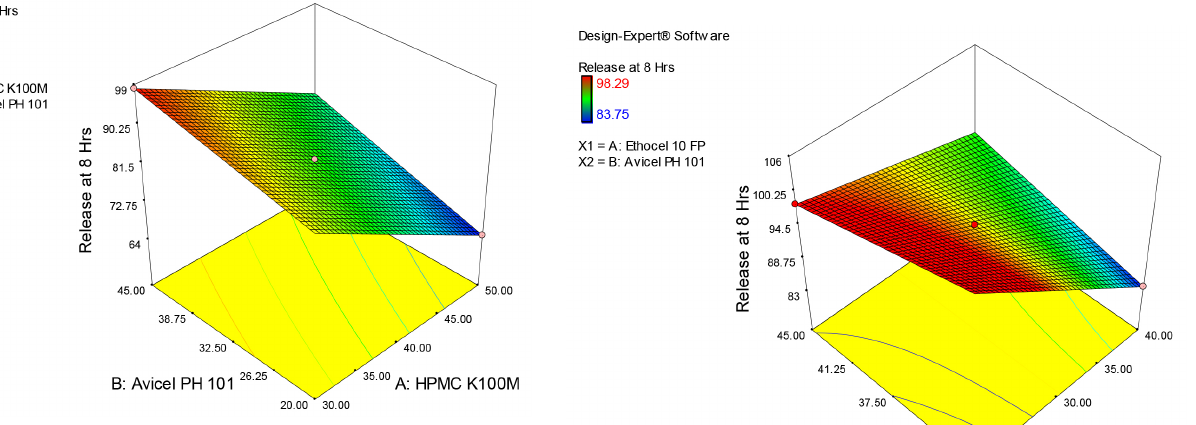
FIGURE 6c - Response surface model (RSM) showing effect of independent variables HPMC K100M and Avicel pH 101 on Drug release in 8 hours.